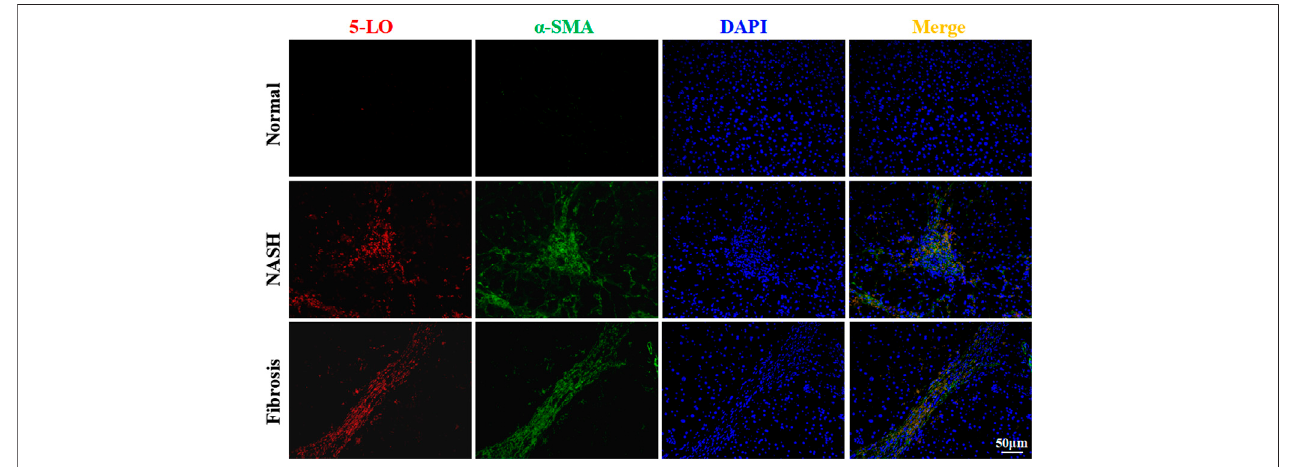
FIGURE 8 | The expression of 5-LO was increased in liver sections of patients with fi brosis. Liver sections were collected from normal individuals or patients with non-alcoholic steatohepatitis or liver fi brosis and were stained with 5-LO and α -SMA. Data are mean ± SEM, n (cid:2)